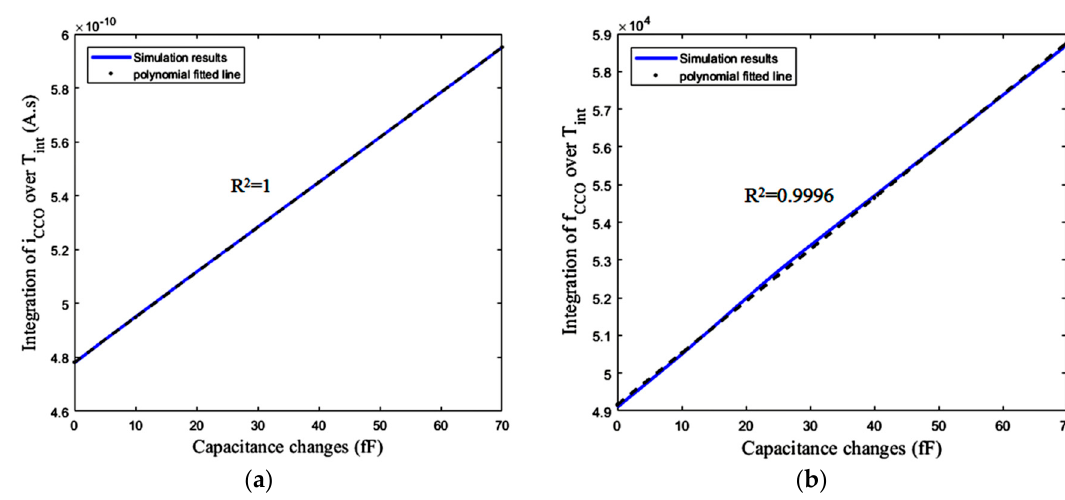
Figure 18. ( a ) Integration of i CCO over T int versus Δ Cs , ( b ) Integration of f CCO over T int versus Δ Cs .